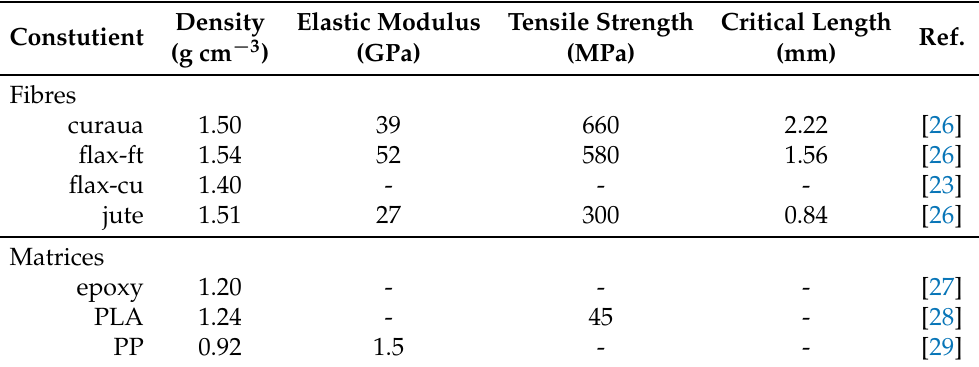
Table 1. Constituent properties.